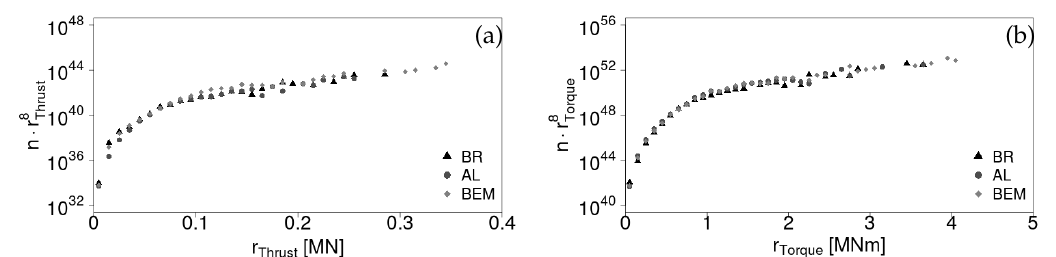
Figure 15. Contribution of ranges to EFL for ( a ) thrust and ( b )